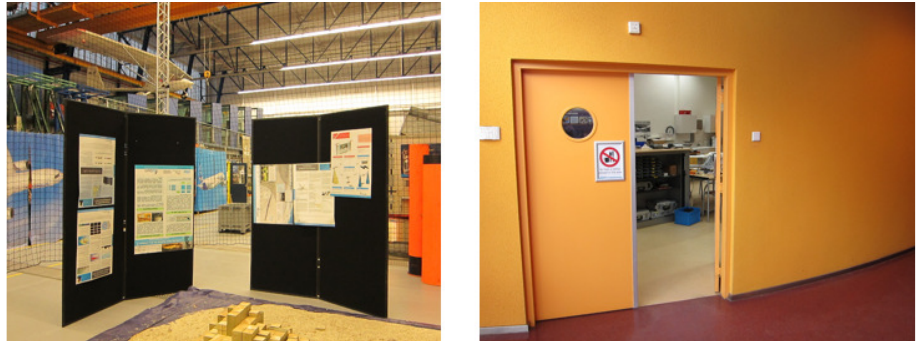
Figure 6. Experimental setup for flight tests with an opened door on the left. The gap between the black walls is 80 cm. The right image shows a real door used for testing.